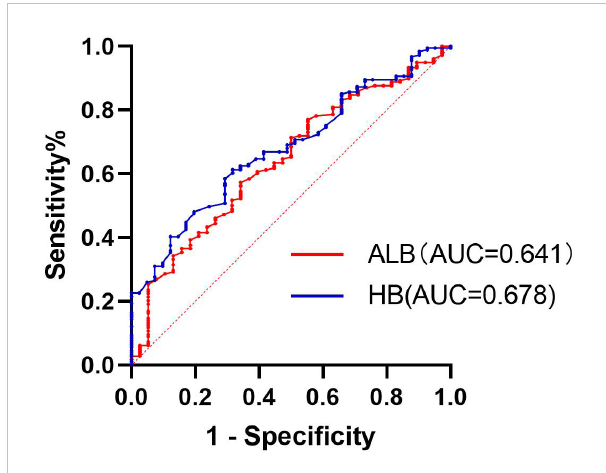
FIGURE 1 The ROC curve of ALB and HB for predicting the occurrence of